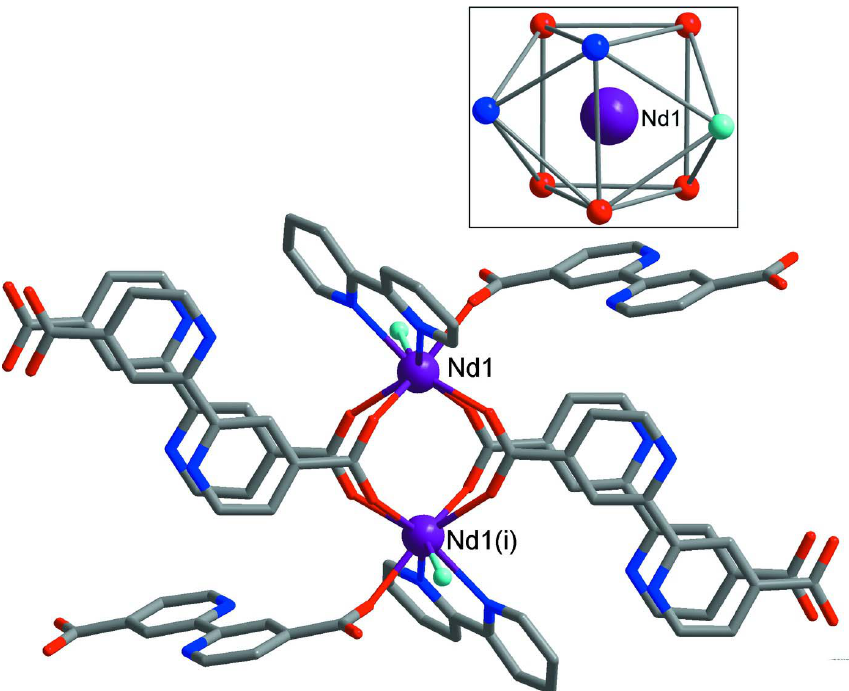
Figure 2 Highlight of coordination environment of the Nd(III) ions. (Key: blue: N; red: O; gray: C; auqa sphere: water molecules; purple sphere: Nd). Hydrogen atoms are omitted for clarity. (Symmetry code: (i) 1–x, 1–y, 1–z) Inset: a view of the bicapped trigonal prism polyhedron around Nd III